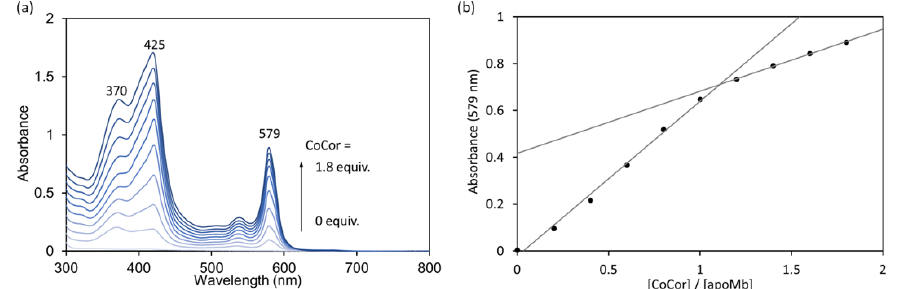
Figure 4. ( a ) UV-vis spectral changes upon addition of a pyridine solution of CoCor (500 μM) to a solution of apoMb. ( b ) Absorption changes at 579 nm. Conditions: [apoMb] = 20 μM in 100 mM potassium phosphate buffer (pH 7.0), [CoCor] = 500 μM in pyridine, 25 °C.